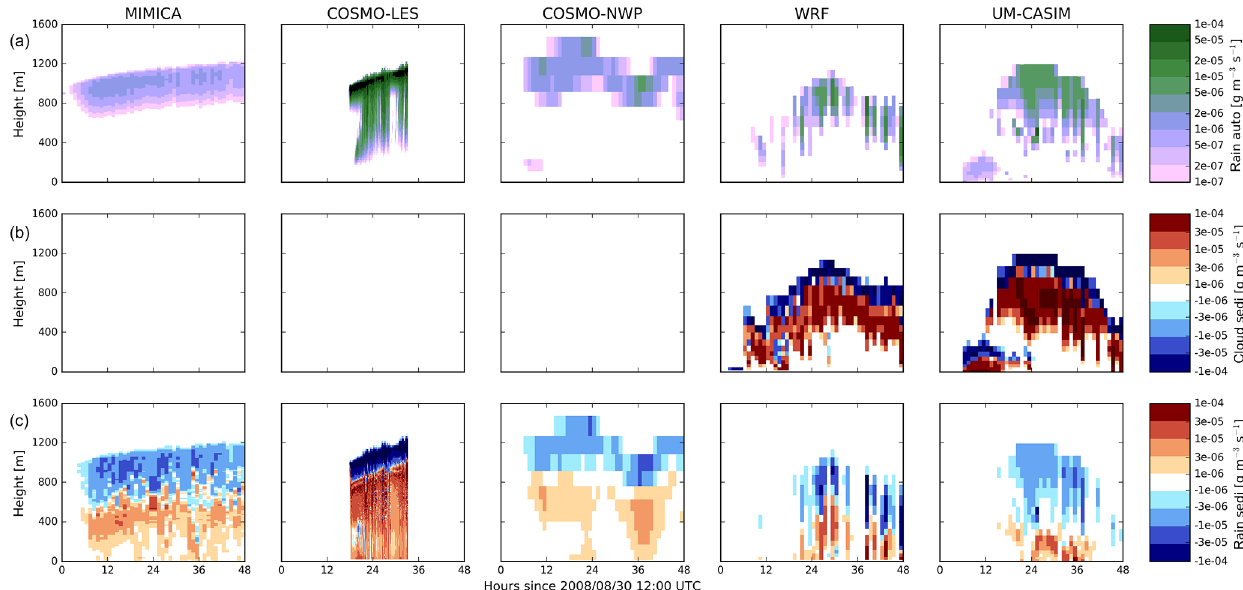
Figure 4. Tendencies of mixing ratios of cloud water and rainwater due to liquid-phase processes for simulations with a prescribed CDNC of 30cm − 3 and no cloud ice permitted (CDNC30_NOICE). (a) Autoconversion of cloud droplets to rain, (b) sedimentation of cloud droplets, and (c) sedimentation of raindrops. Results are shown (from left to right) from the MIMICA, COSMO-LES, COSMO-NWP, WRF, and UM-CASIM models. Note that only WRF and UM-CASIM simulate the sedimentation of cloud